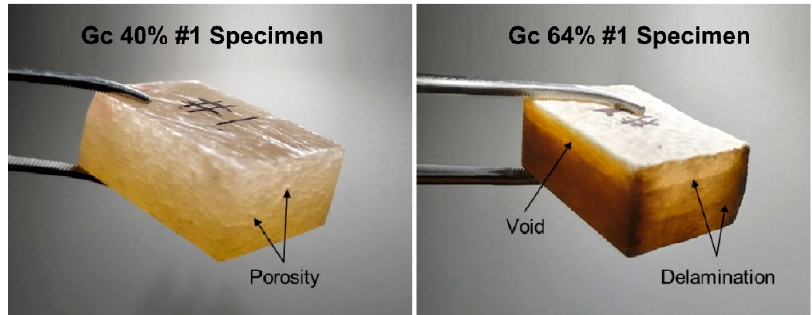
Figure 5. Specimens cut from two hull plates.